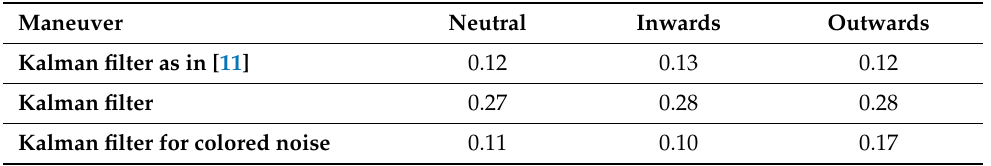
Table 6. Root mean square estimation errors for the three estimation algorithms on the Circular track with the rider in neutral position, leaning inwards, and leaning outwards (in